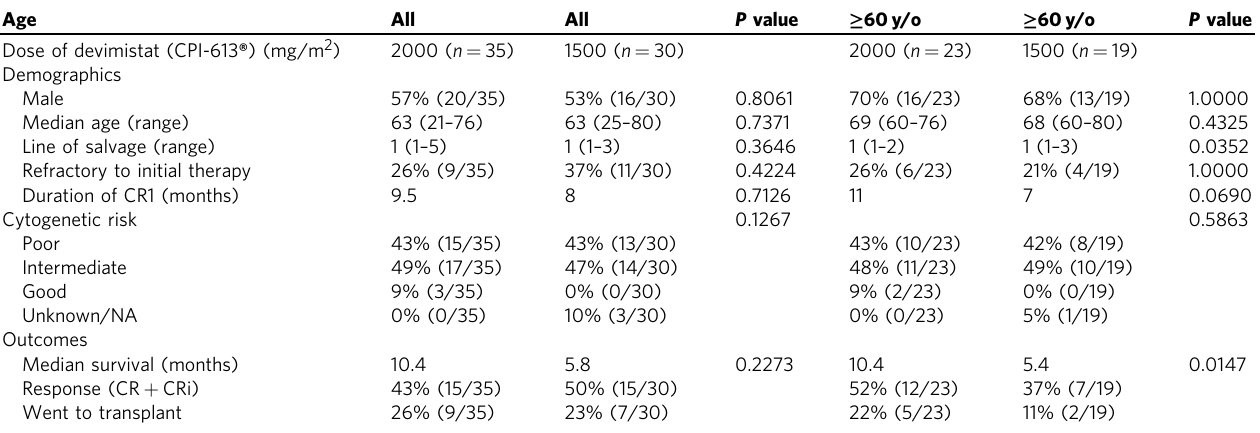
Table 1 Demographics of 2000 and 1500 mg/m 2 cohorts.